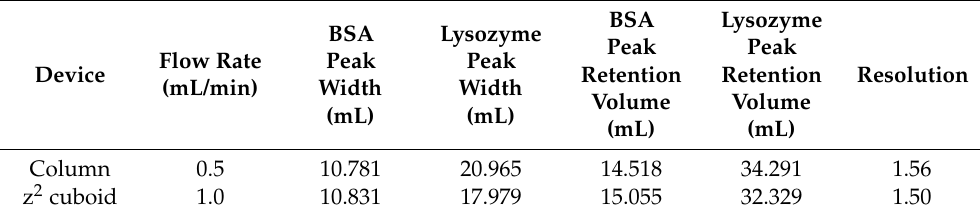
Table 3. Resolution in BSA–lysozyme separation using Sephacryl S-200 HR medium packed 24 mL Tricorn GL 10/300 column and 24 mL z 2 cuboid SEC device (mobile phase: phosphate-buffered saline, pH 7.4; loop: 5 mL; feed: 5 mg/mL BSA + 2.5 mg/mL lysozyme).